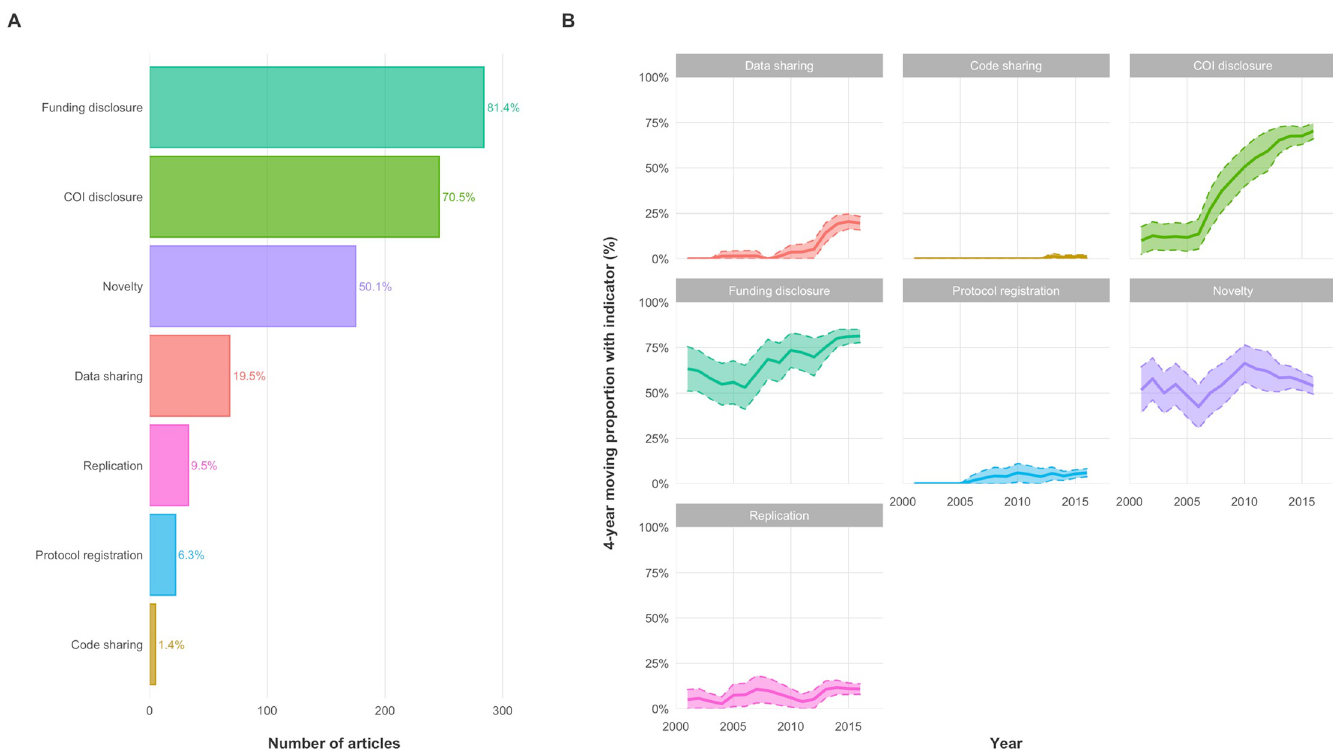
Fig 1. Indicators of transparency and reproducibility across publications and time. (A) Indicators of transparency and reproducibility across 349 research articles (2015–2018). Most publications included COI or Funding disclosures, but few mentioned Data, Code, or Protocol sharing. Similarly, most claimed Novelty but few mentioned a Replication component. (B) Indicators of transparency and reproducibility across time on the basis of manual assessment. These graphs merge data from this study on 349 research articles (2015–2018) with similar data from 2 previous studies on another 590 PubMed articles (2000–2018) [20,22].Proportions are displayed as a 4-year centered moving average. The shaded region indicates the 95% CI. The most notable change is that of COI disclosures, the reporting of which increased from 12% in 2000 to 76% in 2018. The data underlying this figure can be found on OSF at http://www.doi.org/10.17605/OSF.IO/E58WS. CI, confidence interval; COI, Conflict of interest; OSF, Open Science